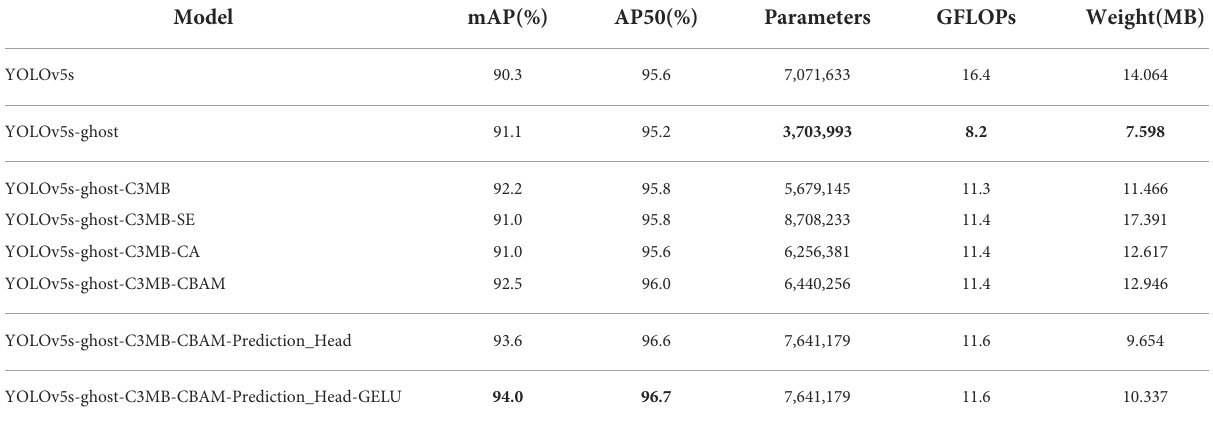
TABLE 4 Results of the ablation experiment on the ALDOD testing set. Model